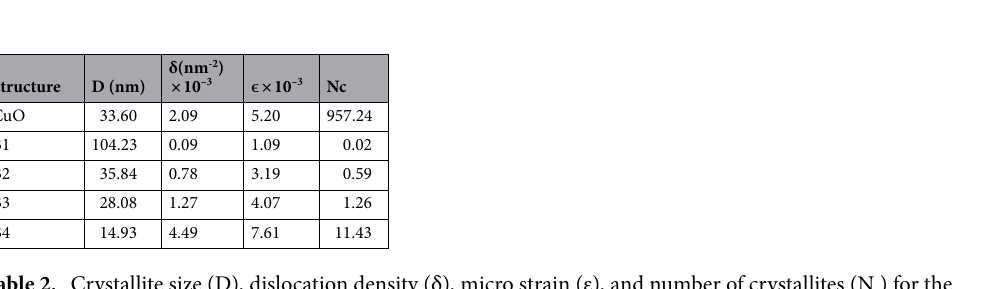
Table 2. Crystallite size (D), dislocation density (δ), micro strain (ε), and number of crystallites (N c ) for the most prominent peak (−111) of CuO-NPs and CMC/CuO nanocomposite films.